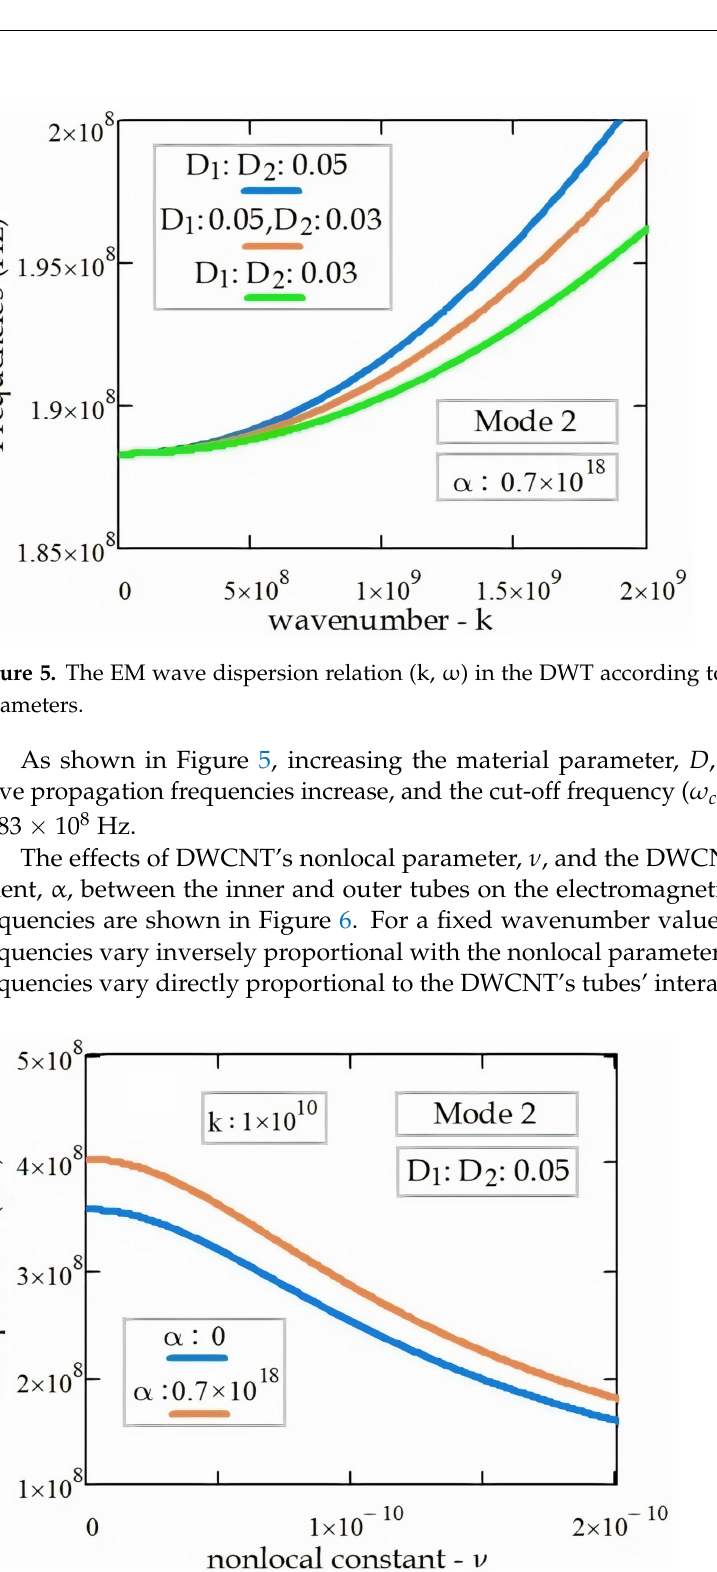
Figure 6. Frequencies of EM wave propagation in the DWCNT for a fixed wavenumber of k = 1 × 10 10